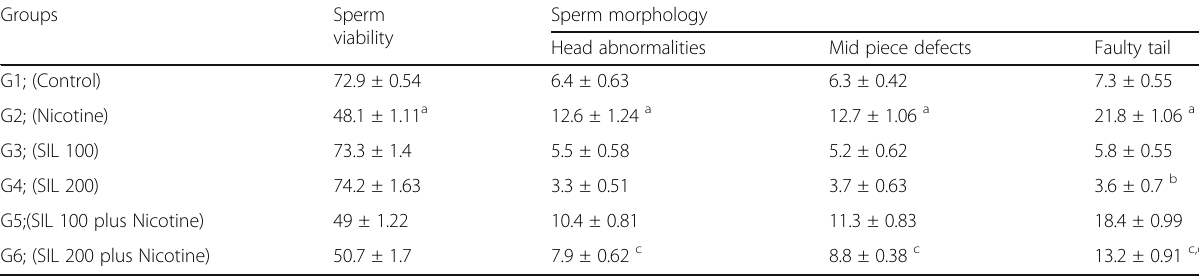
Table 2 Comparison of quantitative sperm viability and morphology of sperm in study groups